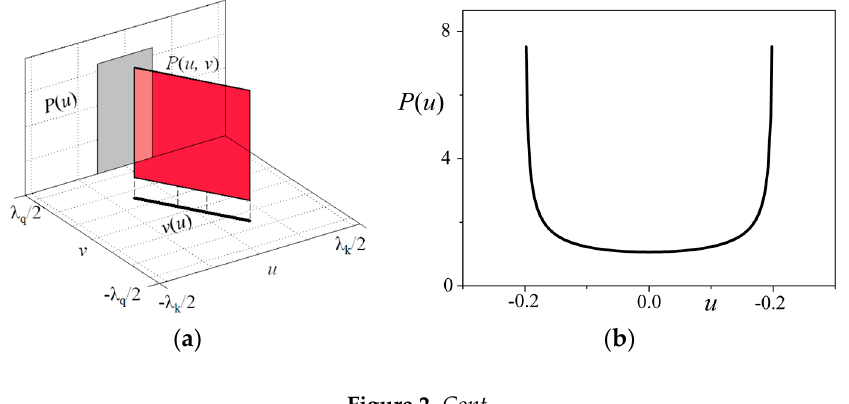
Figure 2. Cont. Figure 2.